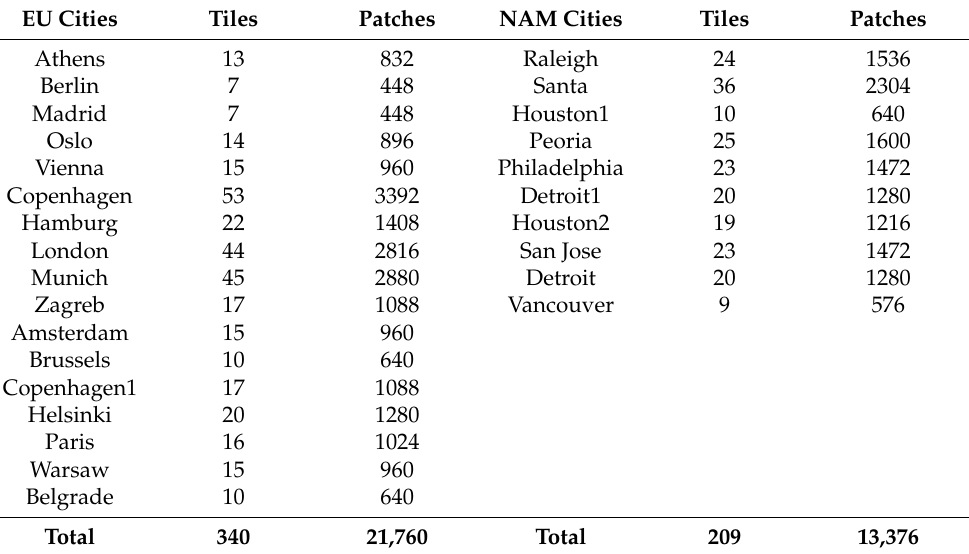
Table 1. Overview of the compiled GBDX dataset: European (EU) and North American (NAM) cities in the dataset together with the number of tiles and patches generated from the tiles for BFP